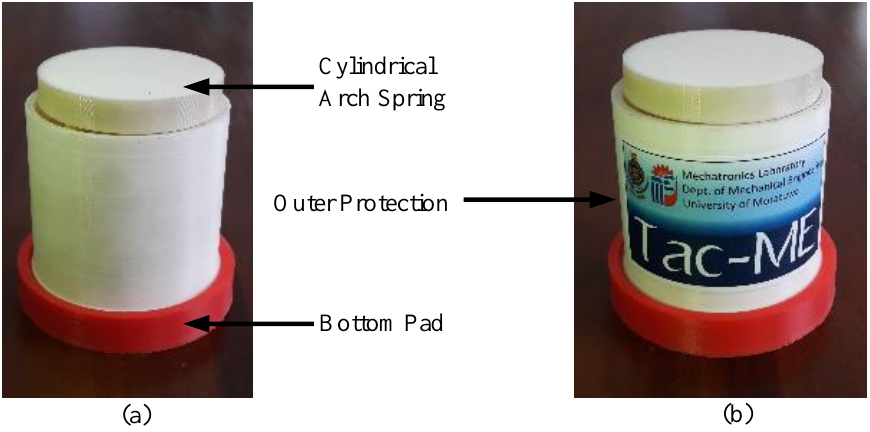
Figure 19. ( a ) Assembled sensor package; ( b ) “Tac-ME”: a 1-DoF Tactile sensor with the insertion of conductive polymer based sensing